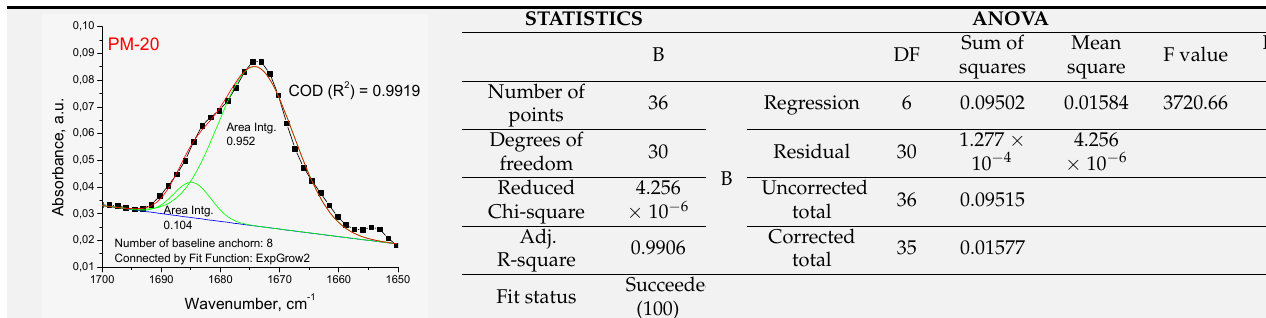
Table A4. Sample P-20.